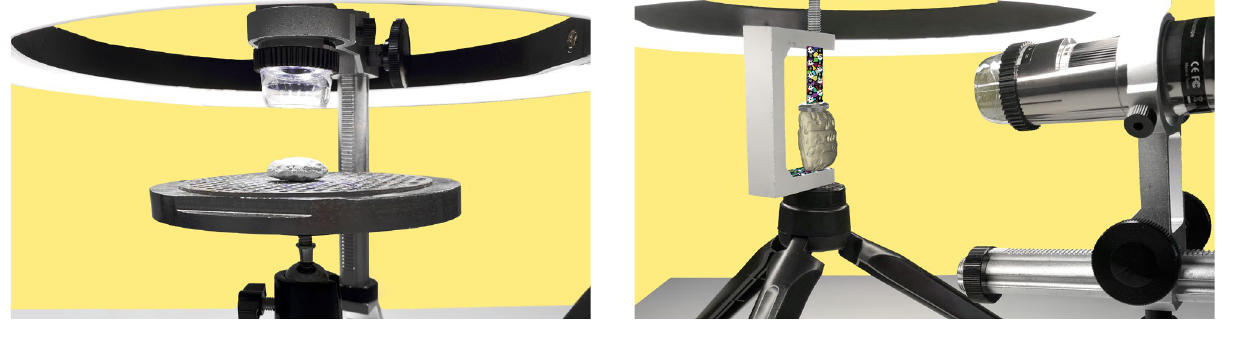
Figure 6 . Setup of the second acquisition test, using the screw clamp coaxial to the rotating